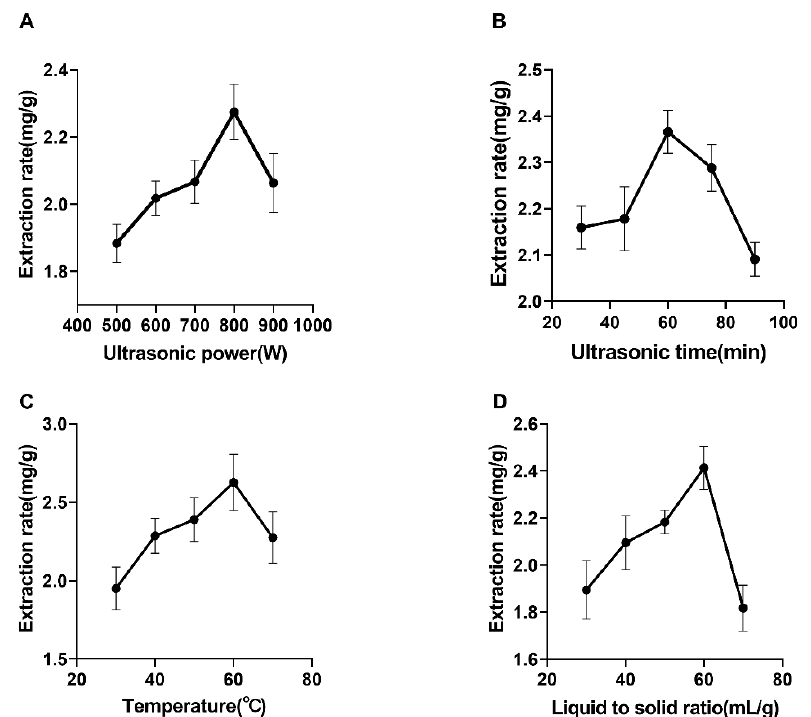
Figure 1. Single-factor experimental results about the ultrasonic-assisted extraction of syrin- gopicroside from S. oblata leaves. Different variables were presented in sequence: ultrasonic power ( A ), ultrasonic time ( B ), temperature ( C ), and a liquid-to-solid ratio ( D ). Data was expressed as mean ± standard deviation ( n = 3).